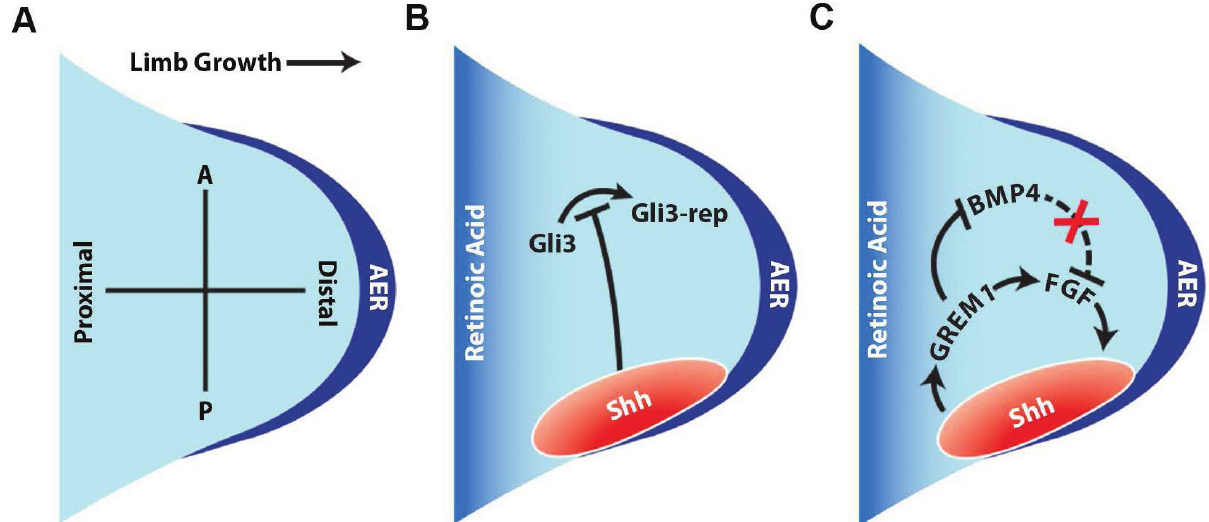
Figure 3. HH signaling and limb development. ( A ) Schematic outlining the different axises of the developing limb. Limb bud formation is initiated at the defined region of the embryonic axis. The proximal-distal (PD) axis is defined by the direction of the limb outgrowth and the antero-posterior (AP) axis is defined by the sequence of the digits 1 (thumb) to 5 (little finger); ( B ) In the developing limb bud, an apical ectodermal ridge (AER) is formed at the distal region of the bud. In the AER region, FGF signaling is initiated in a posterior-anterior fashion forming the AER-FGF zone. Retinoic acid (RA) signaling regulates the proximal development of the limb, whereas the distal region (progression zone) is controlled by multiple signaling factors. FGF signaling initiates the HH signaling in the posterior region of the limb bud and the expression of HH signaling is maintained by HOX genes, Tbx and Fgf8 expression. HH signaling inhibits the constitutive processing of Gli3 to its repressor form (Gli3-rep); ( C ) The posterior region contains high Gli3A and low Gli3-rep and reverse is observed in the anterior region. Following activation, Grem1 (BMP antagonism) functions are required to relay the HH signals to the AER to maintain FGF signaling, thus forming a HH-Grem1-FGF feedback loop in the developing limb